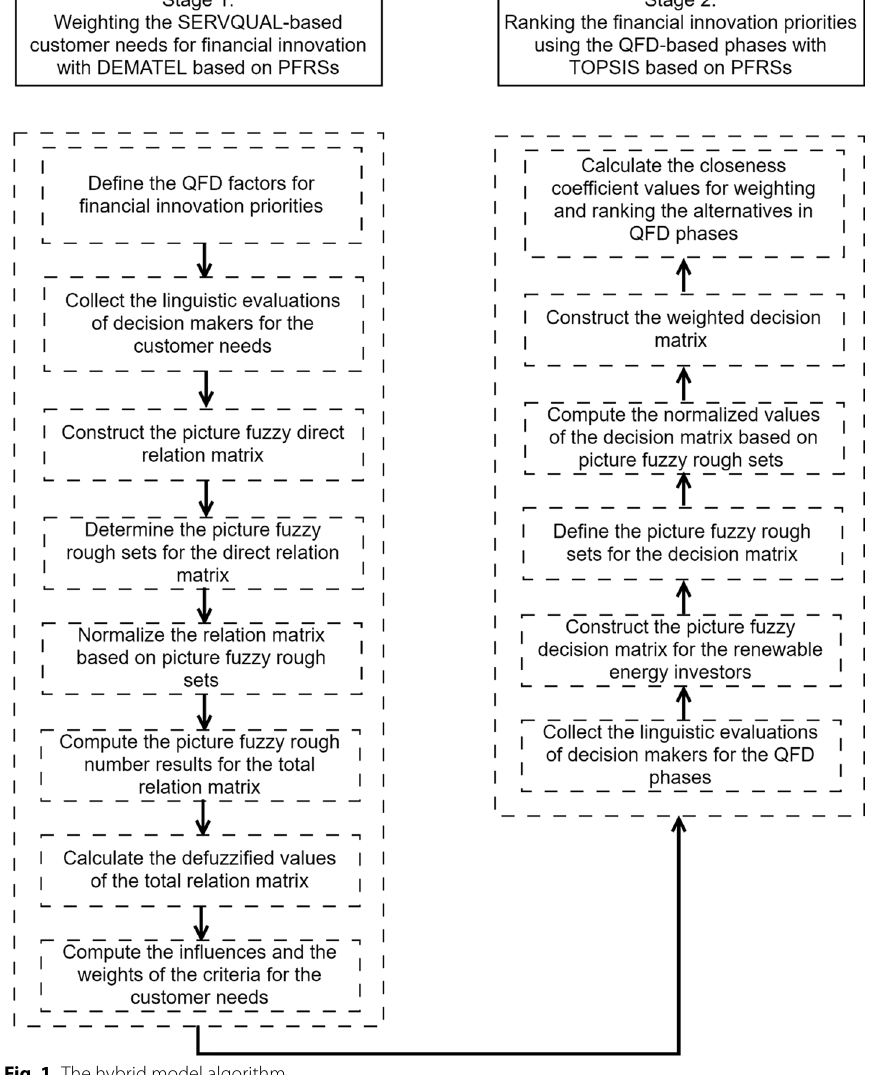
Fig. 1 The hybrid model